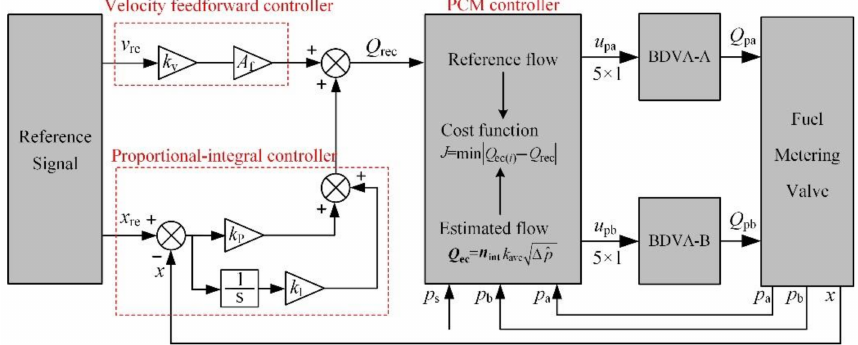
Figure 9. Position control schematic of the proposed fuel metering